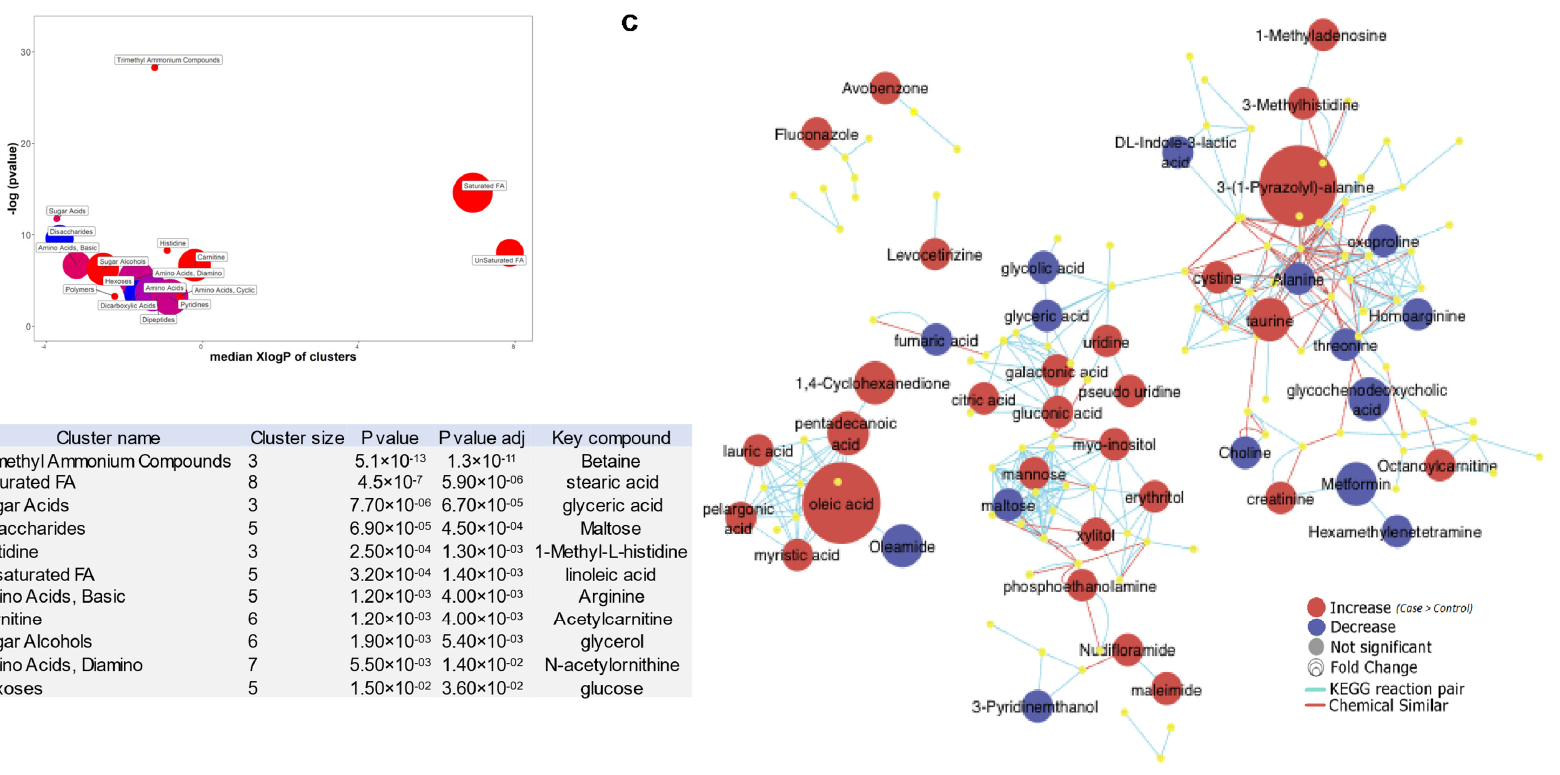
Figure 5. ( A ) ChemRICH analysis plot. Y-axis shows the most significantly altered clusters. Cluster color shows the proportion of increased or decreased metabolites compared to control (red = increased, blue = decreased, purple = mostly decreased). Cluster size indicates the number of compounds in each cluster. Chemical enrichment statistics were calculated by the Kolmogorov–Smirnov test. Only significantly different enrichment clusters (raw p < 0.05) are shown. ( B ) Statistics table for metabolite clusters. ( C ) MetaMapp metabolite network visualization. Red nodes indicate increased metabolites in BC compared to control, while the blue indicates a decrease. Node size indicates the magnitude of fold-change. Compounds are connected by KEGG reaction pair (blue line), and chemical similarity (red line).